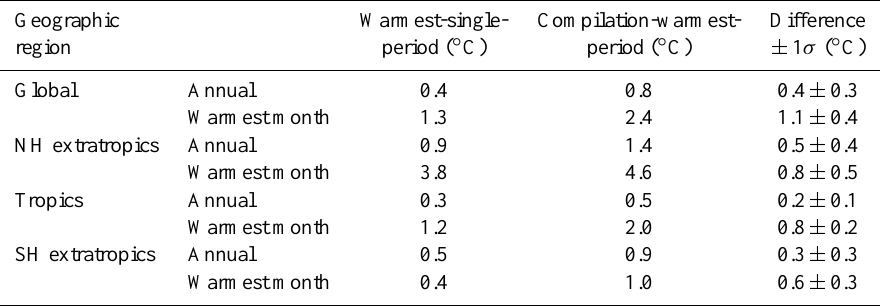
Table 2. MMM overestimation of LIG maximum warmth. Simulated MMM LIG temperature anomalies ( ◦ C) for the single-warmest-period and for compilation-warmest-periods. Values are given for annual mean temperatures and for temperatures of the warmest month as well as for four different geographical regions: global, NH extratropical (30–90 ◦ N), tropics (30 ◦ S–30 ◦ N) and SH extratropical (90–30 ◦ S). The last column gives the difference between the two methods and the inter-model spread (1 σ ). All values are anomalies compared to simulated pre-industrial temperatures. The warmest-single-period is the largest 50-year temperature anomaly found in the regionally averaged temper- ature evolution. On the other hand, the compilation-warmest-periods follows from a regional average over the highest 50-year temperature anomalies found in each individual grid cell within that region. Calculations are performed for the 130–120ka period of the LIG. Geographic Warmest-single- Compilation-warmest- Difference region period ( ◦ C) period ( ◦ C) ± 1 σ ( ◦ C) Global Annual 0.4 Warmest